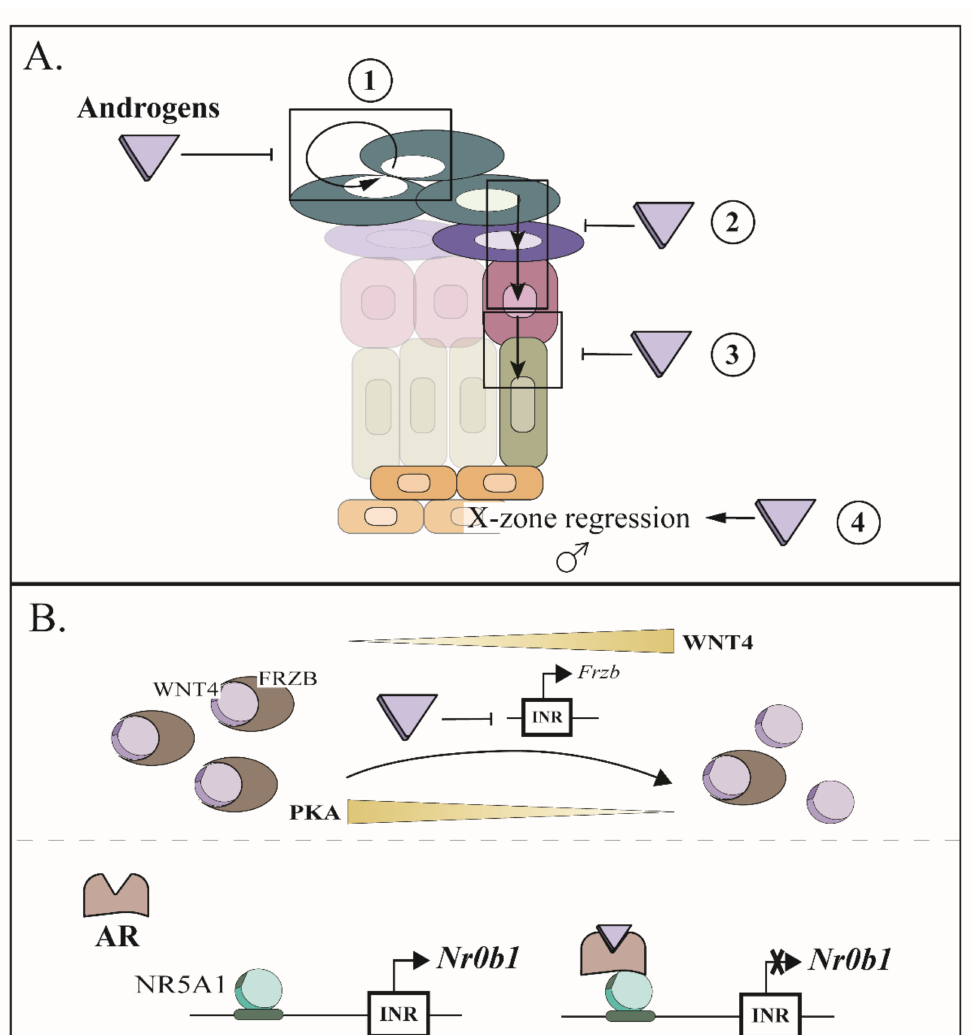
Figure 4. Androgens affect adrenocortical maintenance: ( A ) Androgens act at several levels to regulate the maintenance of the adrenal cortex. 1 (cid:13) Androgens can limit cortical cell turnover by reducing the proliferation of the capsular stem cells; 2 (cid:13) abolish the contribution of the capsular stem cells to the steroidogenic lineage; 3 (cid:13) limit the differentiation of zG cells into zF cells; and 4 (cid:13) permit the complete regression of the X-zone in male mice. ( B ) Potential molecular action of androgen or its receptor in the adrenal cortex. Global molecular mechanisms regulated by androgens are unclear. It was suggested that androgens could stimulate WNT signaling (and potentially restrain PKA signaling) via the downregulation of the WNT inhibitor Frzb . Liganded AR can also negatively regulate the transcriptional activity of Nr0b1 by binding with